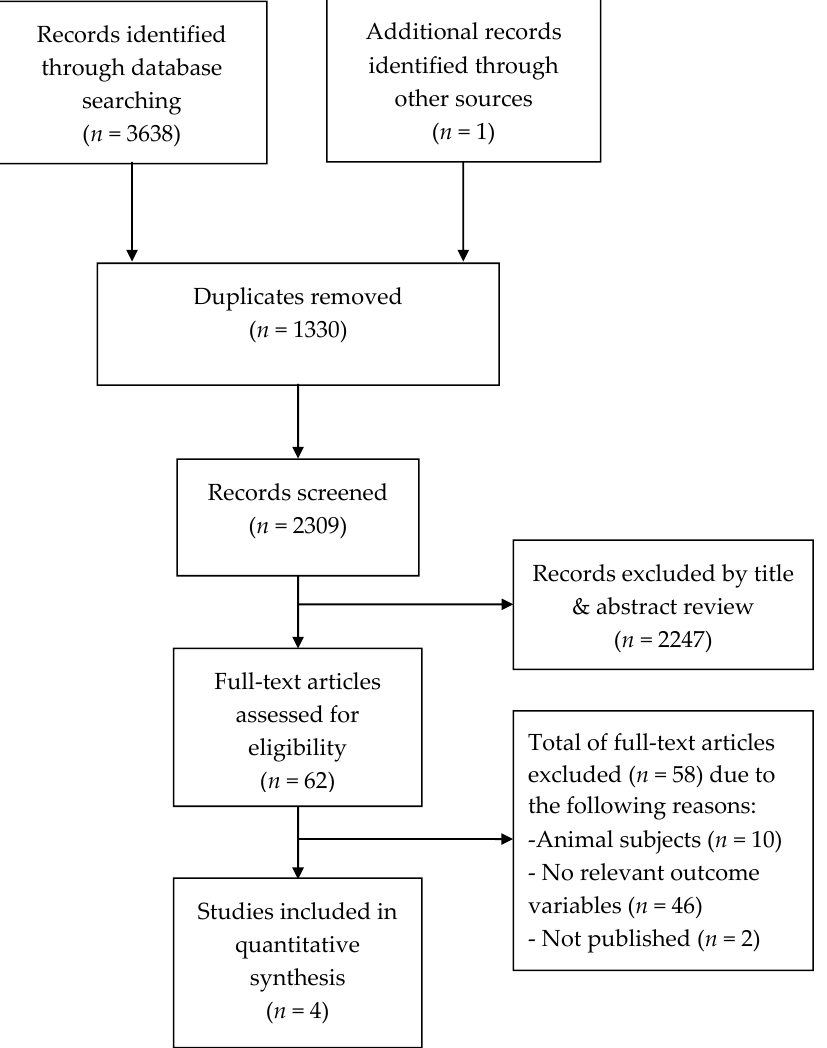
Figure 1. Flow chart of the results of the literature search.